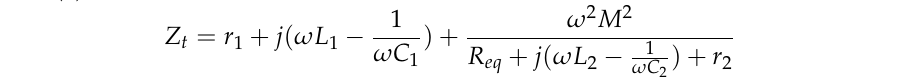
where r 1 and r 2 stand, respectively, for the ground-side and vehicle-side coil’s internal resistances, w is the operating angular frequency (2 * π * 85,000 rad/s) and M is the mutual inductance between the